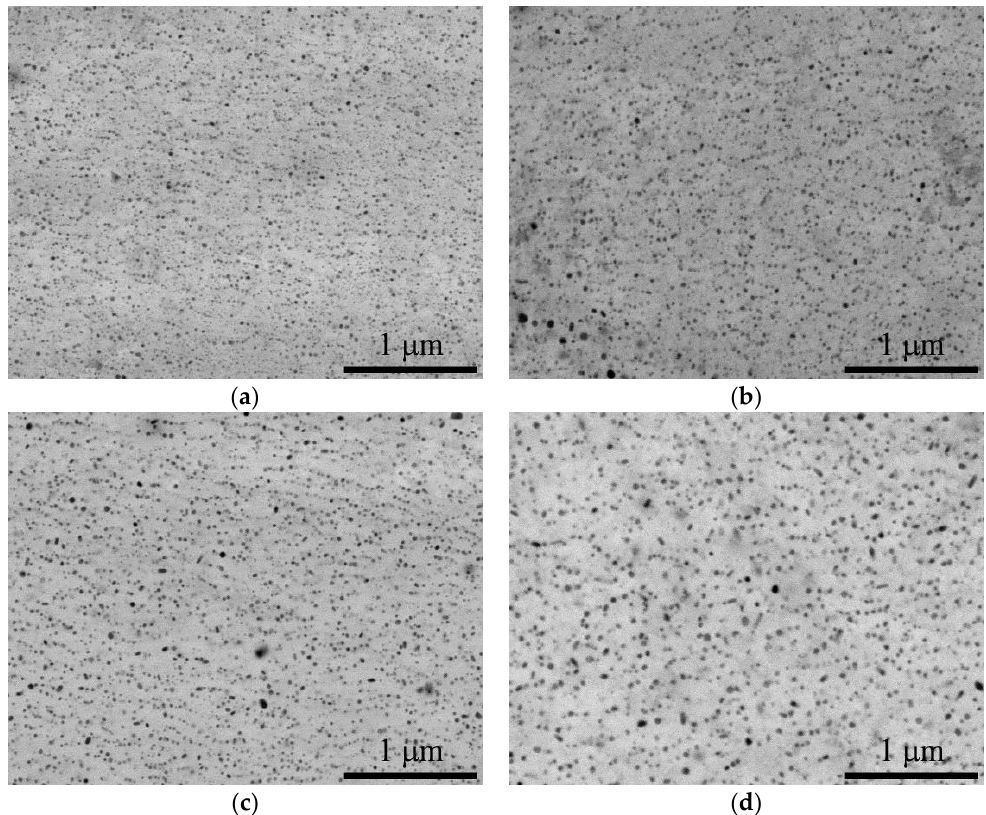
Figure 8. SEM micrographs of oxides dispersed in grain interiors after annealing at 1200 °C for ( a ) 1 h, ( b ) 4 h, ( c ) 16 h, ( d ) 72 h in the Fe-17Cr-7Al-4Y 2 O 3 system.